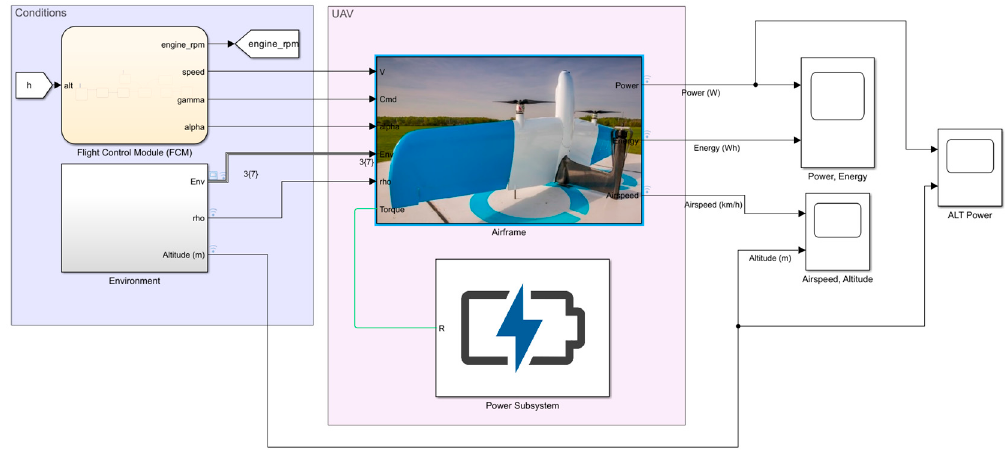
Figure 5. Model for fixed-wing UAV flight simulation.